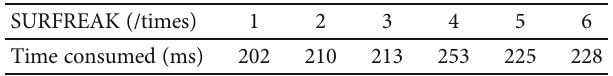
Figure 4: Feature point tracking e ff ect of the KLT optical fl ow algorithm. Table 3: Time consumption statistics of the SURFREAK algorithm.